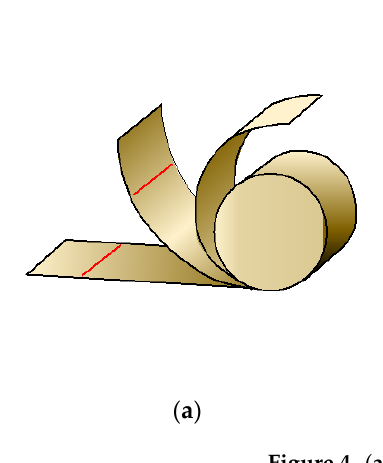
Figure 4. ( a ) An example of a developable surface, where a cylinder is unrolled into a plane. This surface is also ruled, and the pattern of parallel straight lines drawn on the cylinder surface is preserved during the transformation. Figure ( b ) shows an ancient Mesopotamian cylindrical seal (dating to about 5000 BC) and its imprint. [18].